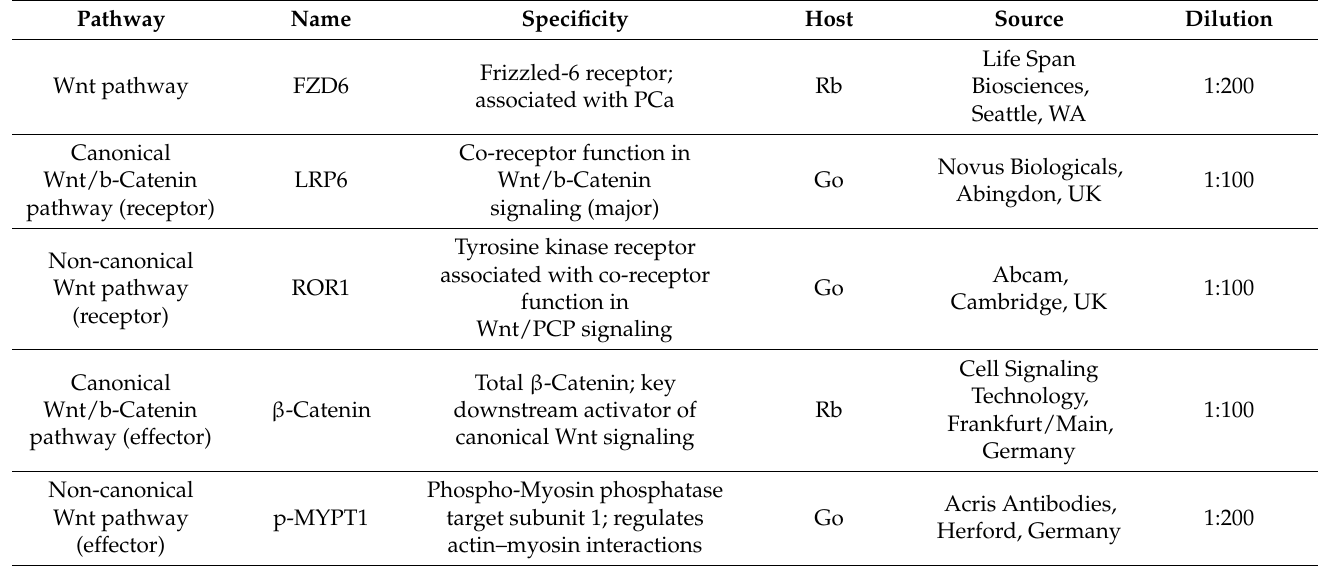
Table 2. Overview of the antibodies used for the detection of FZD6–co-receptor interactions and Wnt downstream effectors. Rb, rabbit; Go,